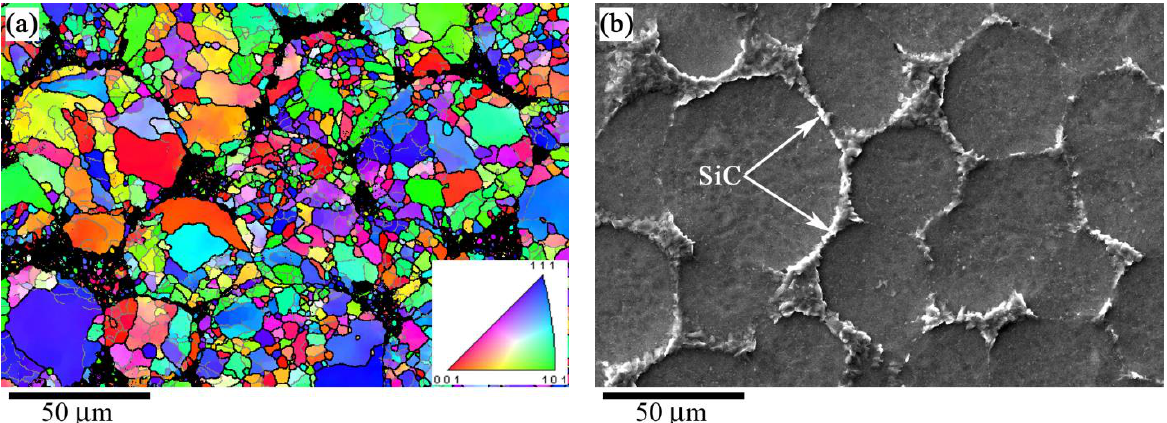
Figure 1. ( a ) The EBSD image after electropolishing and ( b ) the SEM image of the AlMg6/10% SiC MMC microstructure.